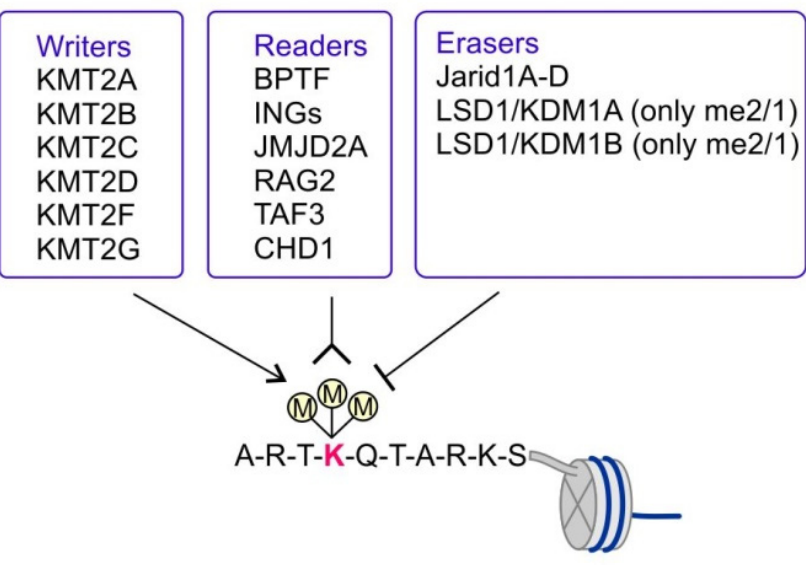
Figure 4. Known writers, readers, and erasers of H3K4 methylation.